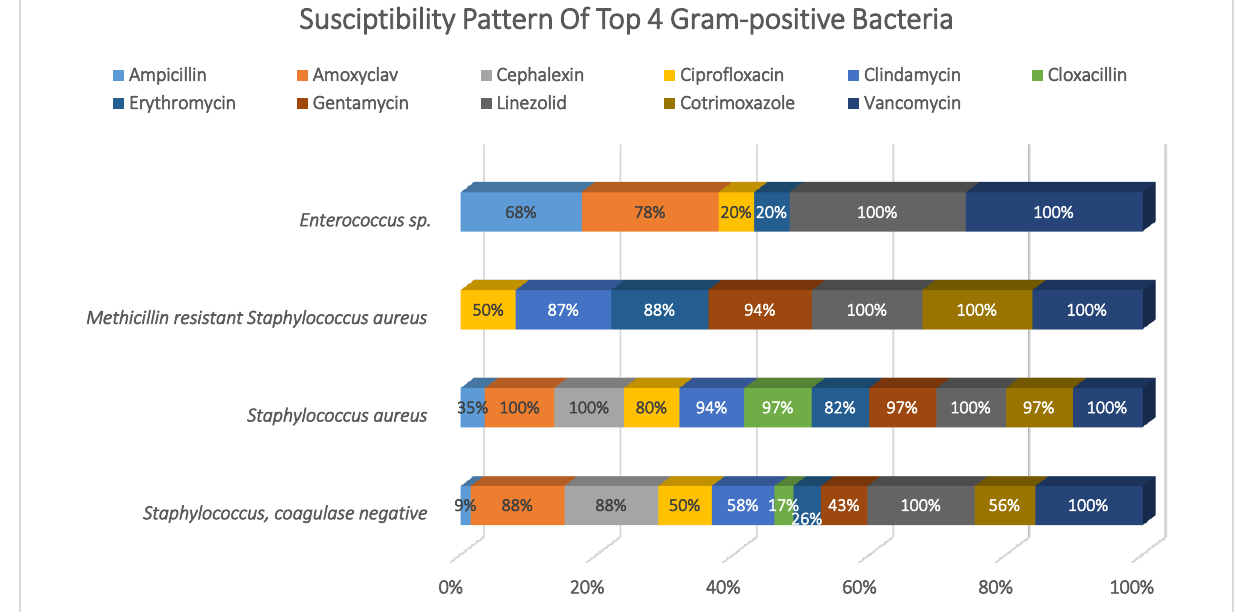
Figure 2. Susceptibility pattern of top 4 Gram-positive